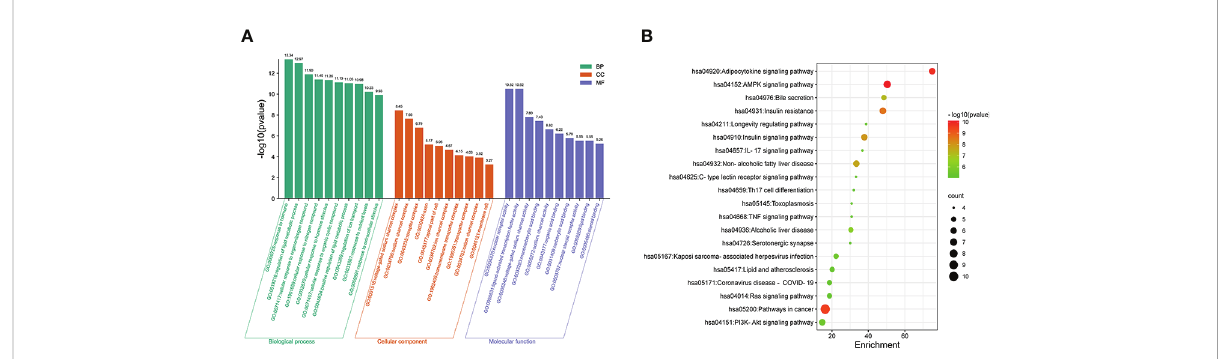
FIGURE 6 Enrichment analysis of GO function and KEGG pathway. (A) GO analysis, including BP, CC, MF; the larger the value of -log10 (pvalue), the more important the item is. (B) The larger the value of -log10 (pvalue), the more important the signaling pathway